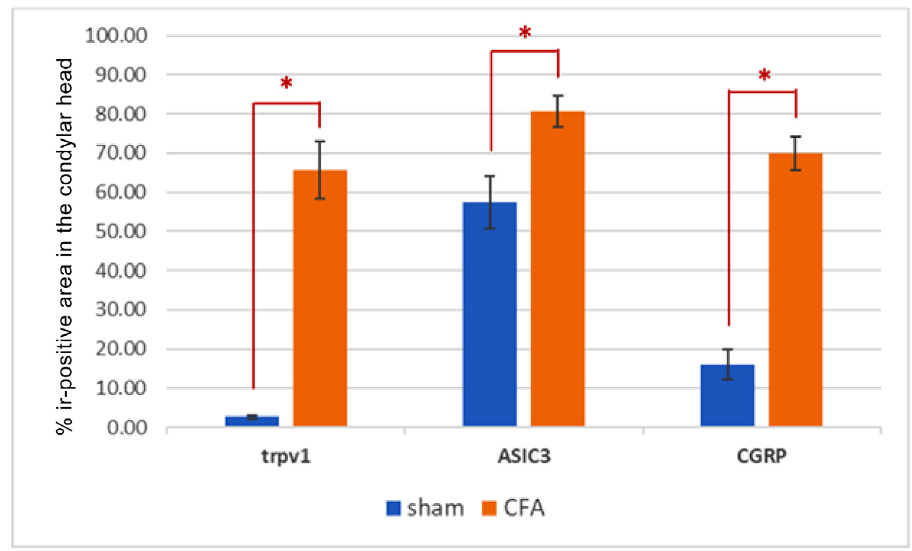
Figure 2- Graph of the percentage of the ir-positive area in the condylar head of the temporomandibular joint in the sham and complete Freund’s adjuvant (CFA) groups according to protein expression. Independent t-test, n=5, p≤